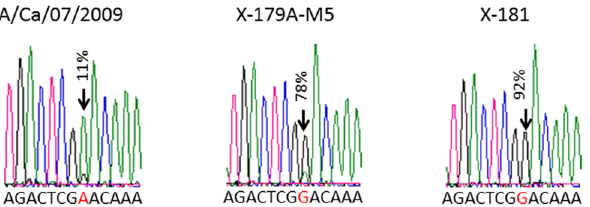
Fig 2. Sanger sequencing of the presence of mutation Asn 146 Asp (A 436 G) that was detected by Illumina sequencing at diffent levels: 11% in A/Ca/07/2009 (H1N1) virus, 78% in X-179A-M5 virus and 92% in X-181